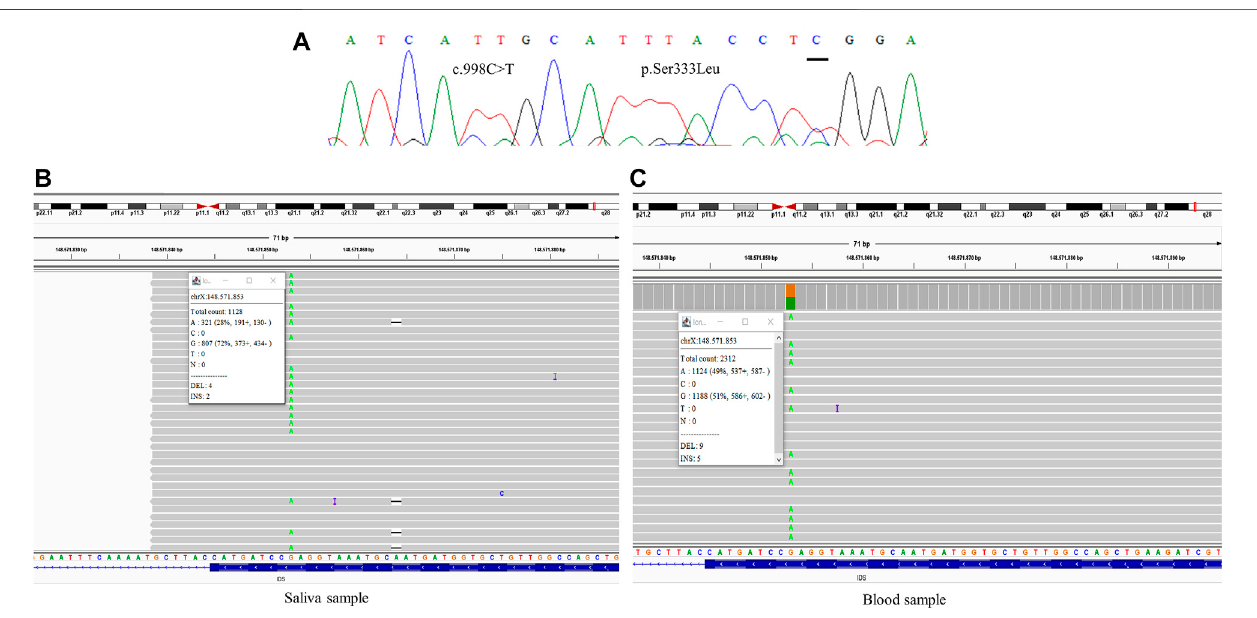
Frontiers in Molecular Biosciences |